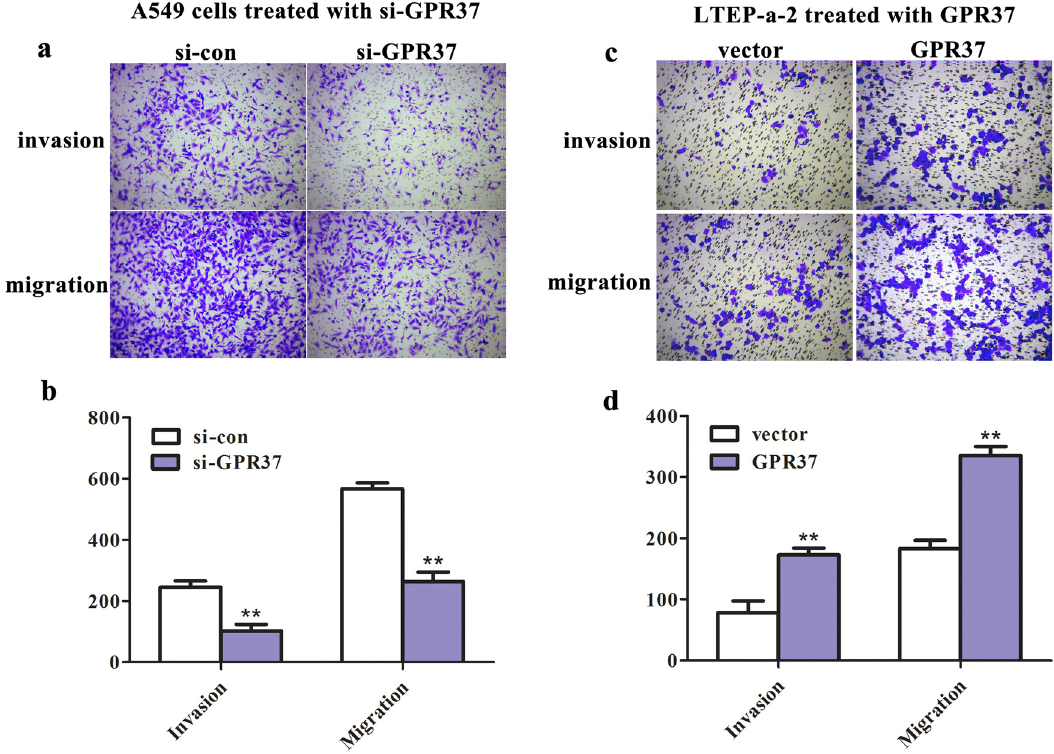
Figure 4: GPR37 contributed to promoting the invasion and migration of LUAD cells. Transwell assay was carried out to measure the invasive and migratory abilities of ( a and b ) A549 cells treated with si - GPR37 ( ** P < 0.01 vs si - con group ) and ( c and d ) LTEP - a - 2 cells treated with pcDNA3.1 - GPR37 ( ** P < 0.01 vs vector group )